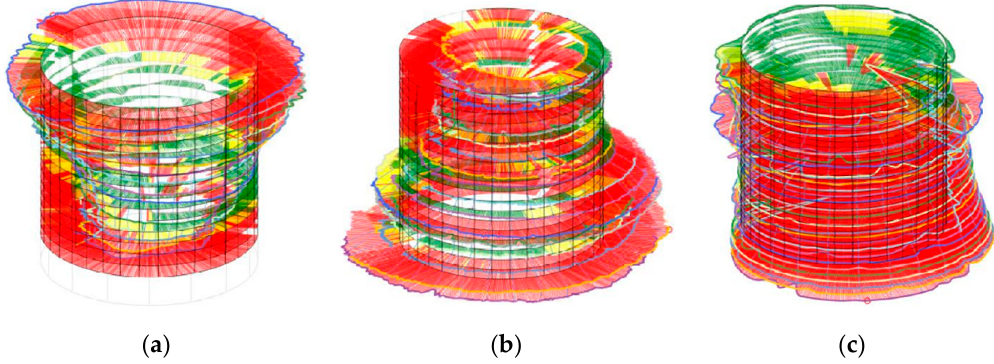
Figure 3. The unevenness of the diameter of the resonance cylinder, the absorption cylinder, and the cavity cylinder (left to right) resulting in asymmetrical cylinders [14]. The nominal values of the diameters are 2.0 mm, 2.5 mm and 8.0 mm respectively. Red/yellow/green: Deviation of the measured value and the nominal value larger than/similar to/smaller than 10 µm, respectively.